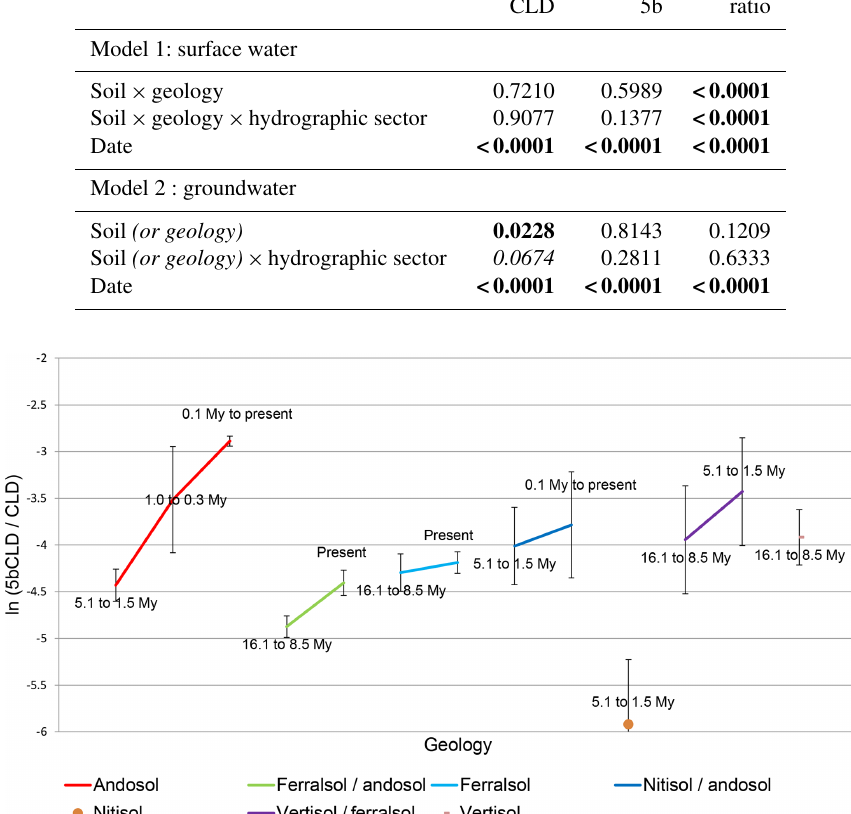
Figure 4. Mean 5bCLD / CLD ratio (natural logarithm) according to soil types and to the age of the geological formations. Ferr_And, Nit_And and Vert_Ferr account for watersheds with two main types of soil, namely ferralsols and andosols, nitisols and andosols, and vertisols and ferralsols. The y values of − 6, − 4 and − 2 correspond to ratio values of 0.002, 0.018 and 0.135,